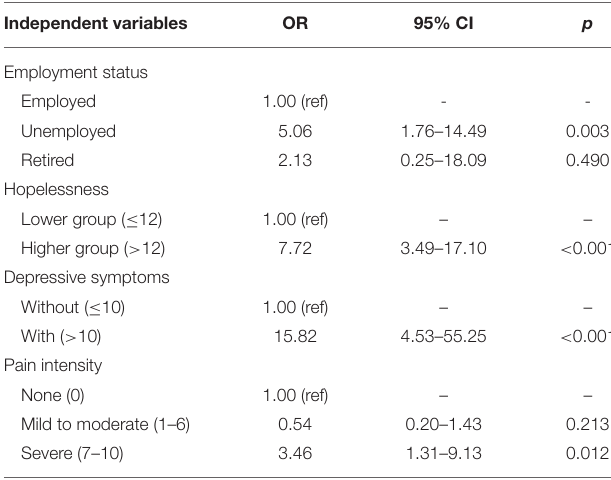
TABLE 2 | Multivariate logistic regression for completed suicide among the rural elderly in China.